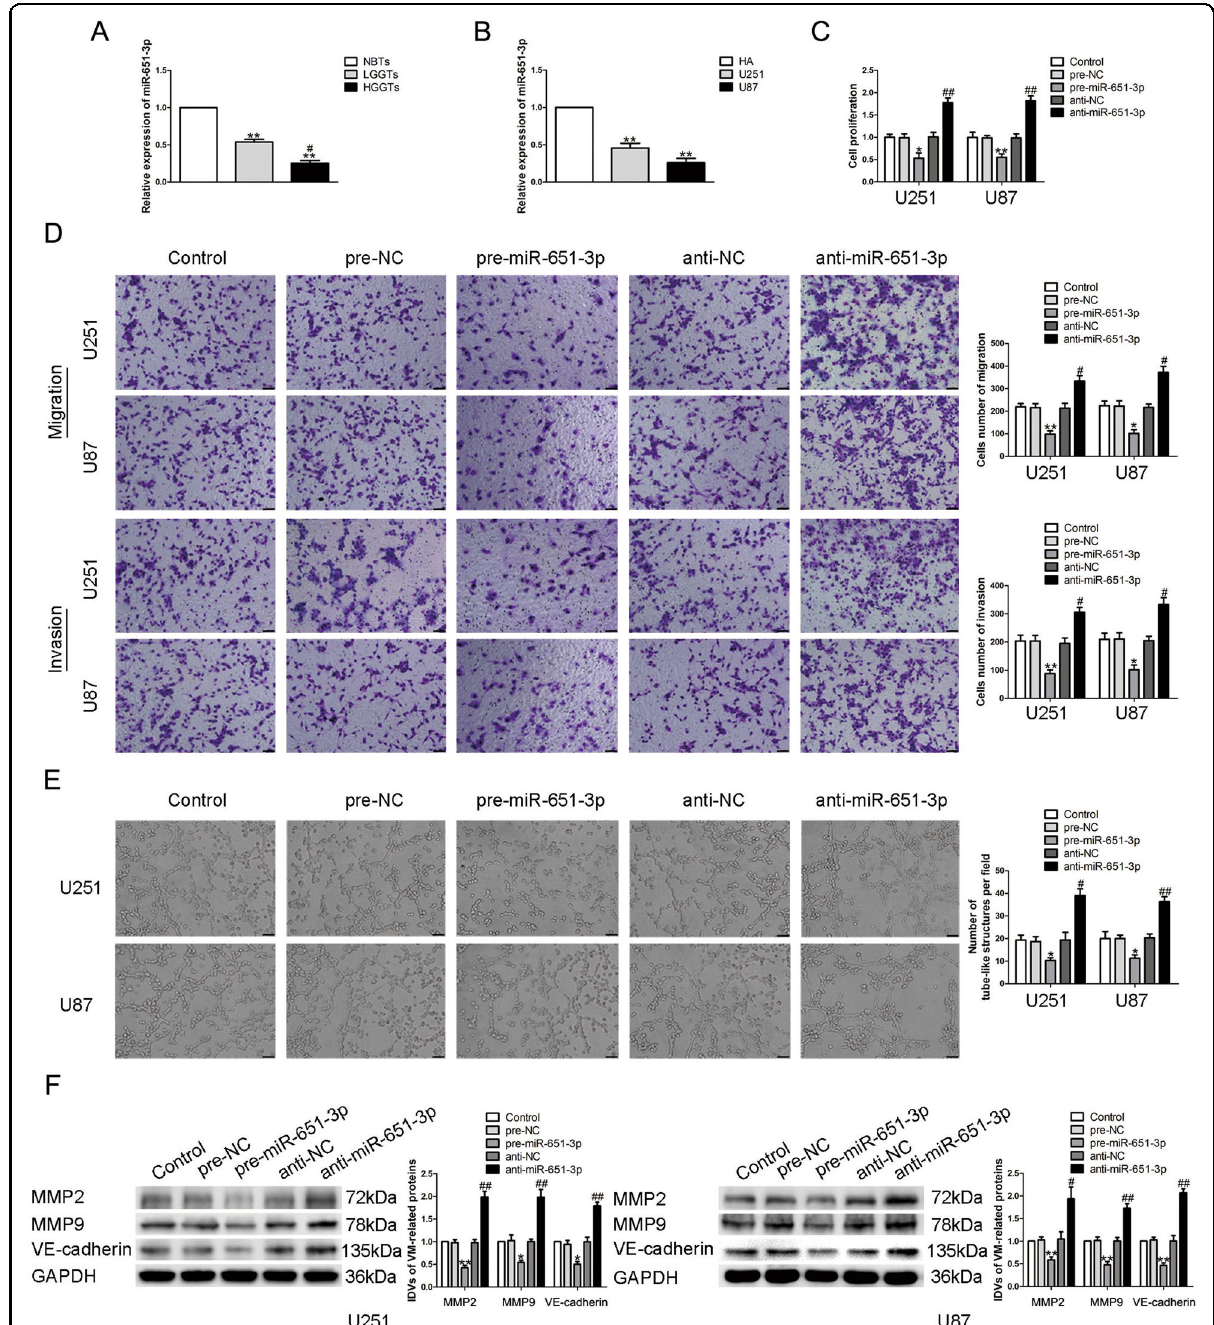
Fig. 4 miR-651-3p endogenous expression and the effect on VM formation in glioma cells. A Expression levels of miR-651-3p in glioma tissues. Data are presented as the mean ± SD ( n = 9, each group). ** P < 0.01 vs. NBTs group; # P < 0.05 vs. LGGTs group. B Expression levels of miR-651-3p in glioma cells. Data are presented as the mean ± SD ( n = 3, each group). ** P < 0.01 vs. HA group. C – E CCK-8 assay, transwell, and three-dimensional culture were applied to evaluate the proliferation, migration, invasion, and tube formation effect of miR-651-3p on U87 and U251 cells. Representative images and corresponding statistical plots are shown. The scale bar represents 50 µm. F Protein levels of MMP2, MMP9, and VE- cadherin regulated by miR-651-3p in U87 and U251 cells. Data are presented as the mean ± SD ( n = 3, each group). * P < 0.05, ** P < 0.01 vs. pre-NC group; # P < 0.05, ## P < 0.01 vs. anti-NC